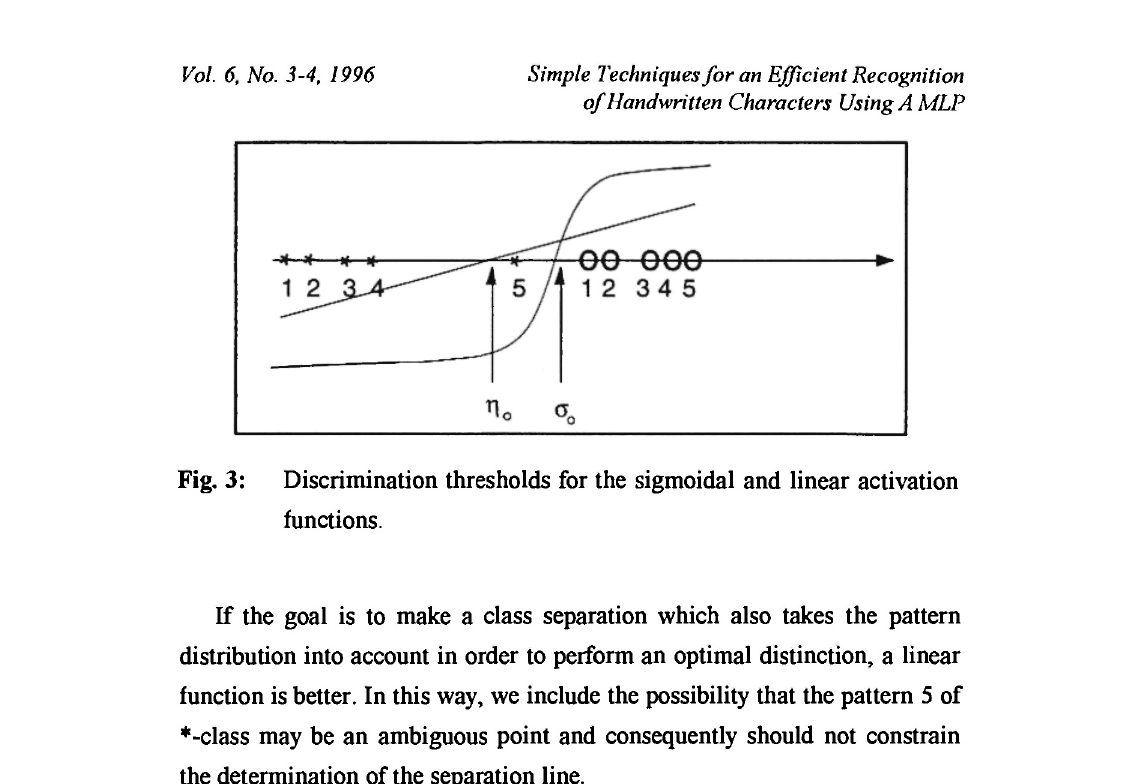
Fig. 3: Discrimination thresholds for the sigmoidal and linear activation